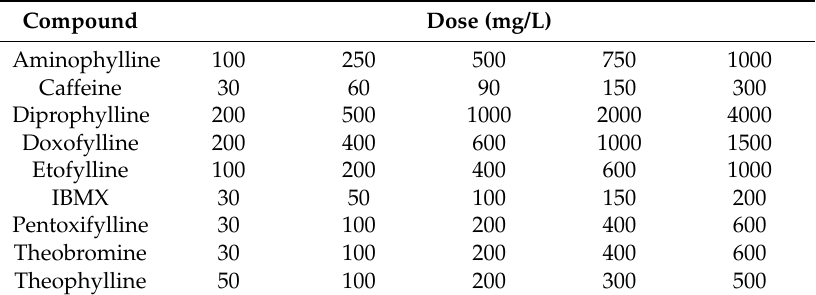
Table 1. The five doses of each methylxanthine compound used in the FET